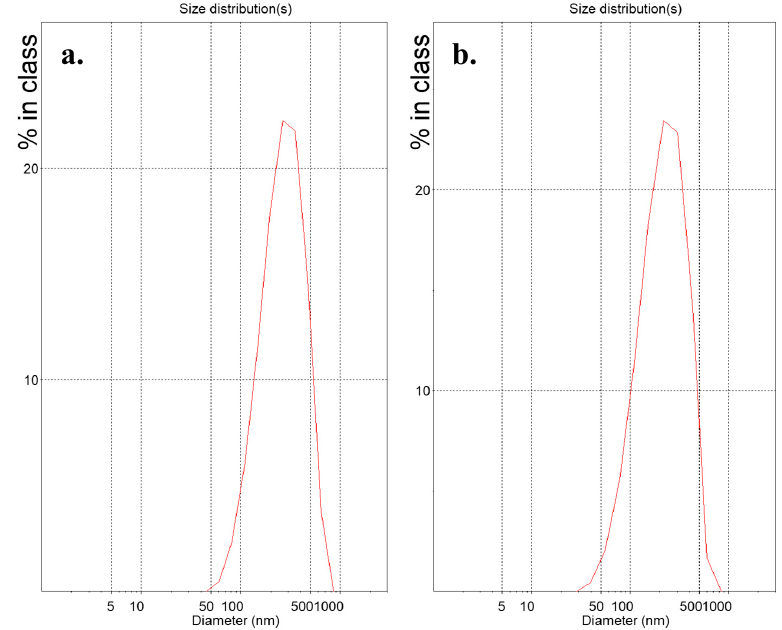
Figure 2. Distribution by intensity ( D I ) of ( a ) HSPC:stearylamine 9:0.25 and ( b ) L- α -phosphatidylcholine (Egg, Chicken) (EPC):cholesterol:stearylamine 9:1.8:0.25 lipidic vehicles with glycerine concentration 20% v/v . The x-axis represents the nanoparticle size, while the y-axis shows the scattered light intensity%.